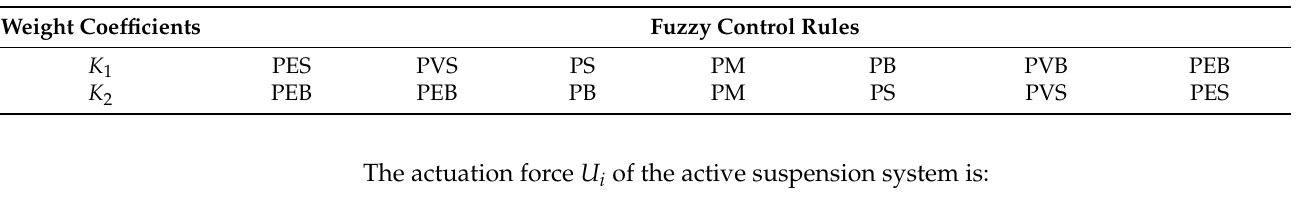
Table 3. The fuzzy control rules of K 2 .